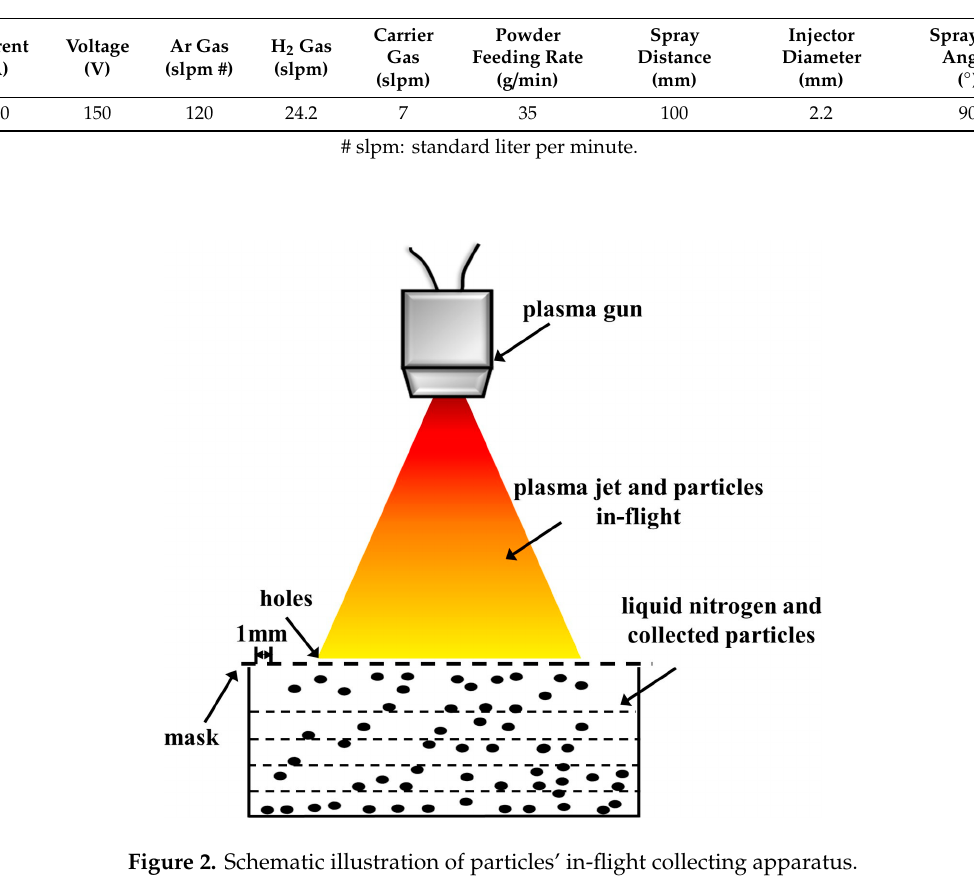
Table 1. Spray parameters of yttria-stabilized-zirconia (YSZ) by supersonic atmospheric plasma spraying (SAPS).